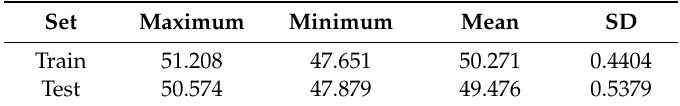
Table 2. Statistical properties of GUR in terms of divided training and testing set.